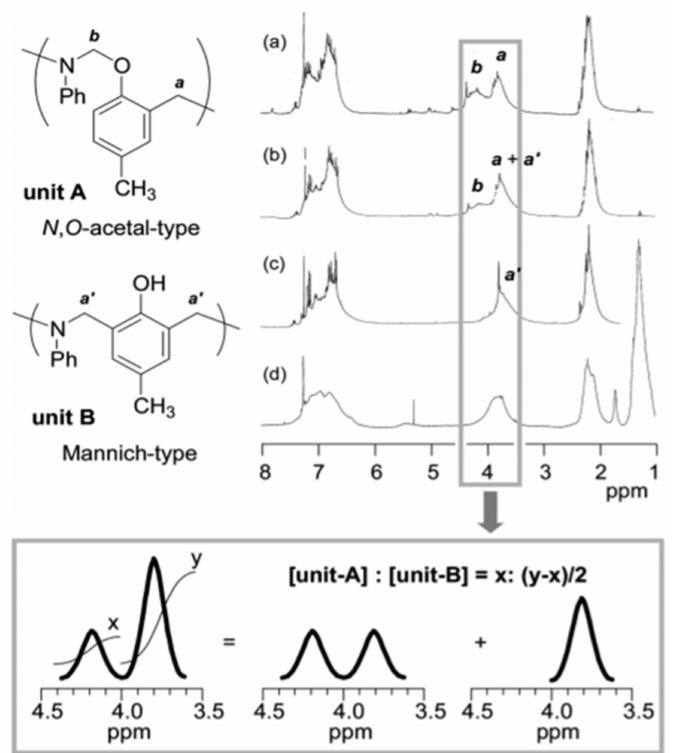
Figure 35. 1 H NMR spectra of the polymer obtained after heating for ( a ) 5 h at 150 ◦ C in the presence of 1 mol% EMI, ( b ) 9 h at 150 ◦ C in the presence of 1 mol% EMI, ( c ) 1 h at 200 ◦ C and ( d ) the polymer obtained by the reaction of the polymer ( c ) and tert -butylisocyanate. [269]. Copyright 2008. Reproduced with permission from American Chemical Society.